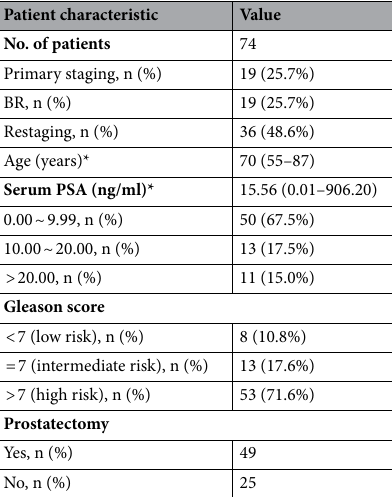
Table 1. Patient characteristics. BR biochemical recurrence. * data are expressed as the median (range).